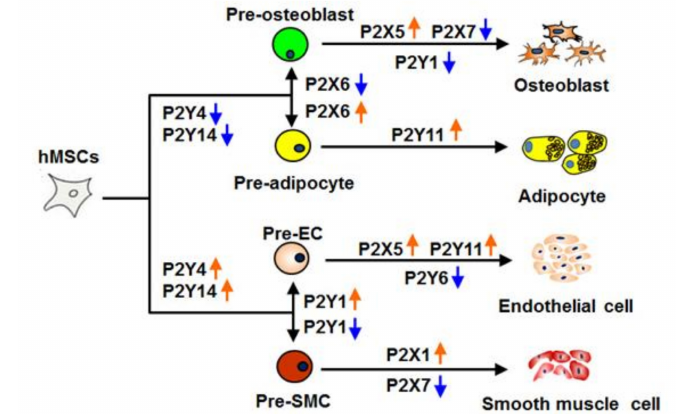
Figure 7. Model of P2 receptor function in MSC commitment. P2Y4 and P2Y14 are indicated to involve in the early di ff erentiation stages, whereas P2Y1 might be a key factor in di ff erentiation towards endothelial and smooth muscle cells. P2X5, P2Y4 andP2Y6 appear to be important in endothelial di ff erentiation, while P2X7 appears to be involved in smooth muscle di ff